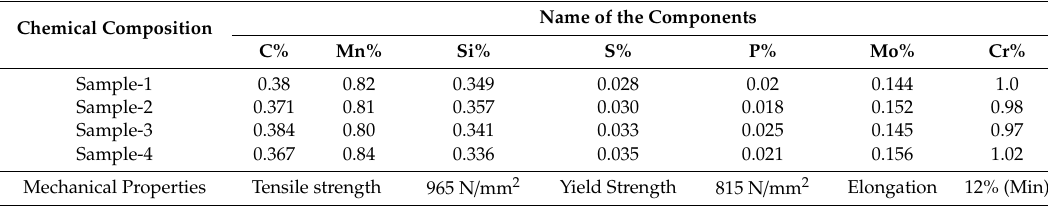
Table 3. Chemical composition of the mill drive